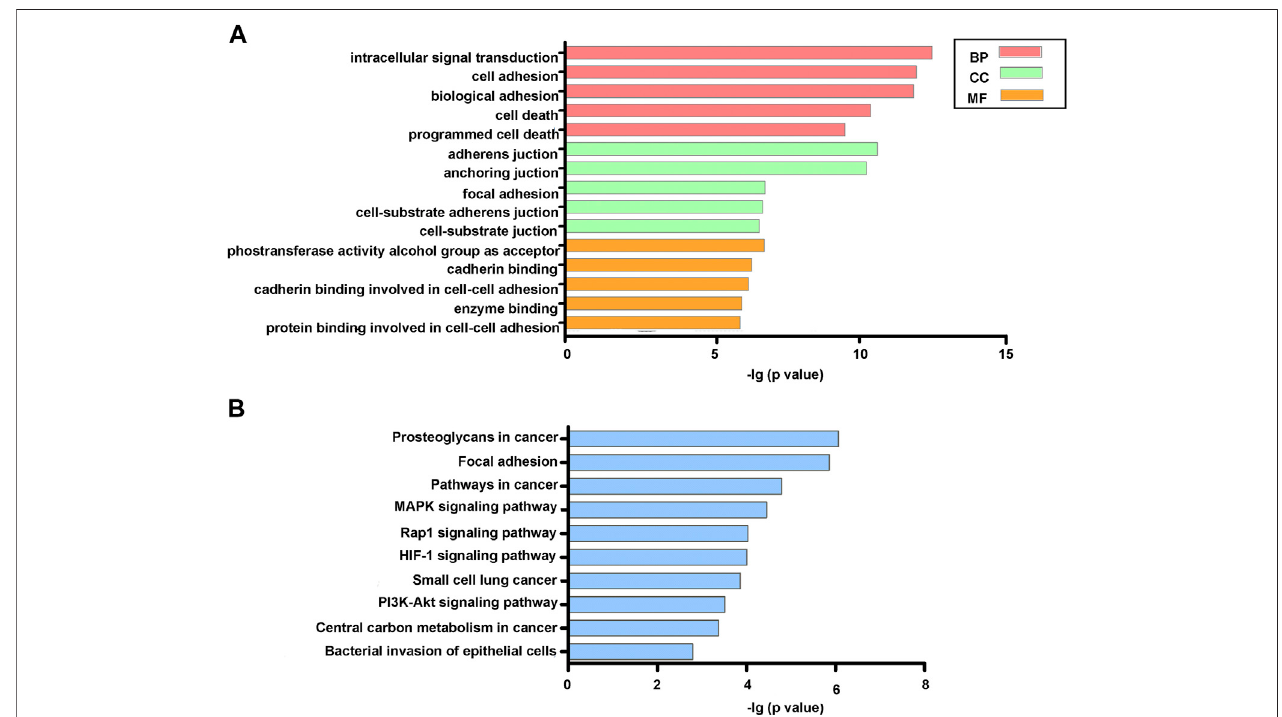
FIGURE 4 | GO (A) and KEGG (B) functional enrichment analysis of